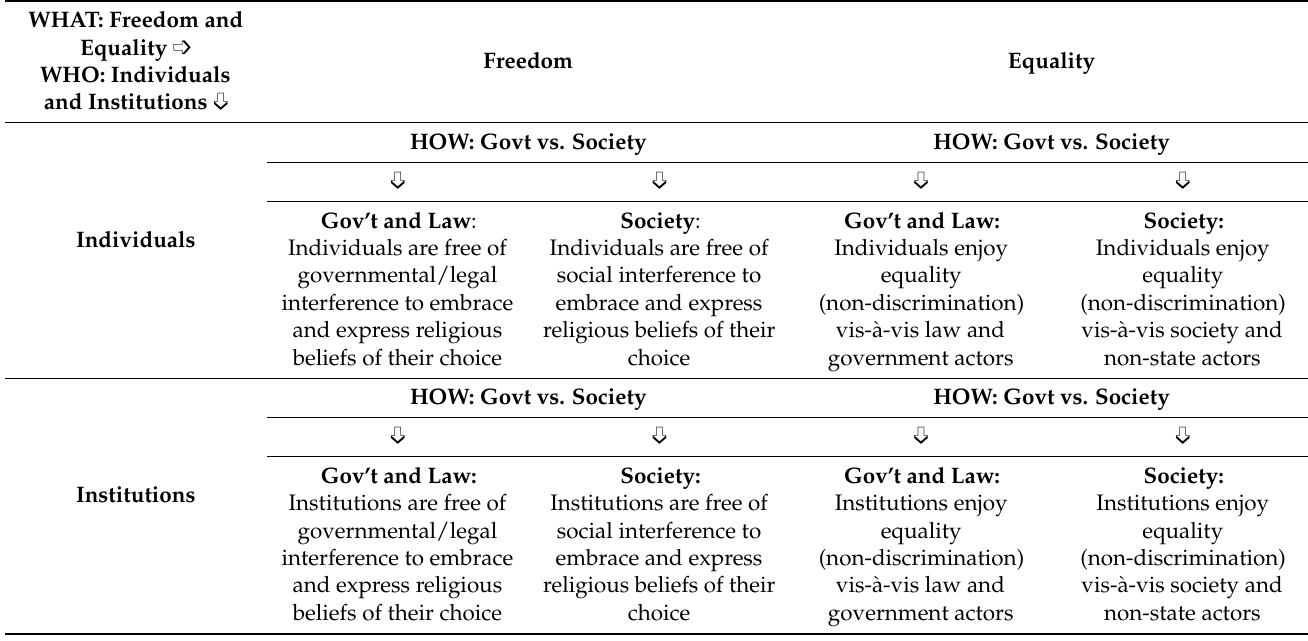
Table 1. The WHAT, WHO and HOW of Religious Freedom: Core